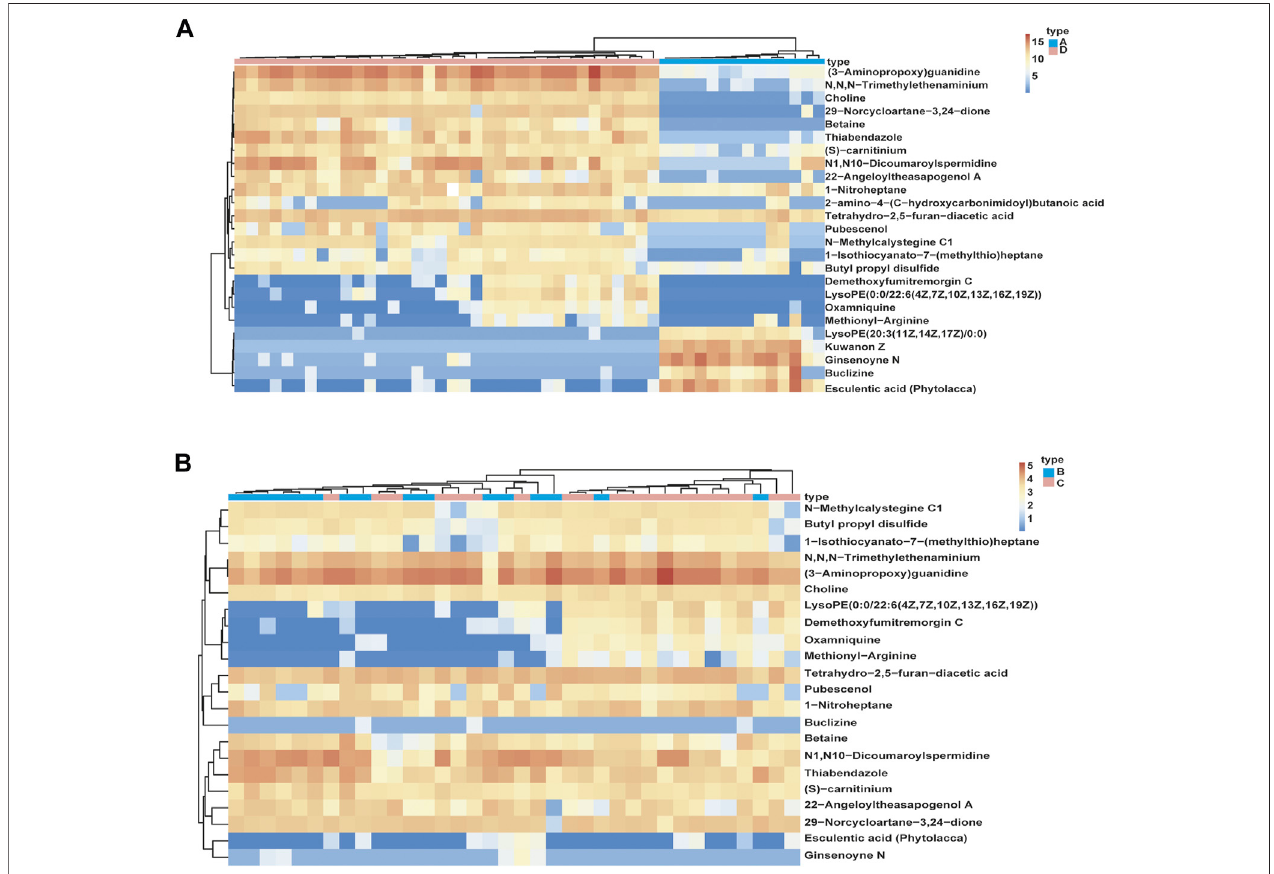
FIGURE 4 | Relationship among different types of leukemia samples, and expression patterns of potential biomarkers in different samples. (A) : Relationship between ALL and AML samples, and expression patterns of potential biomarkers in different samples. (B) : Relationship within AML samples. Group A: Acute lymphoblastic leukemia (ALL), group D (include group B and group C): Acute myeloid leukemia